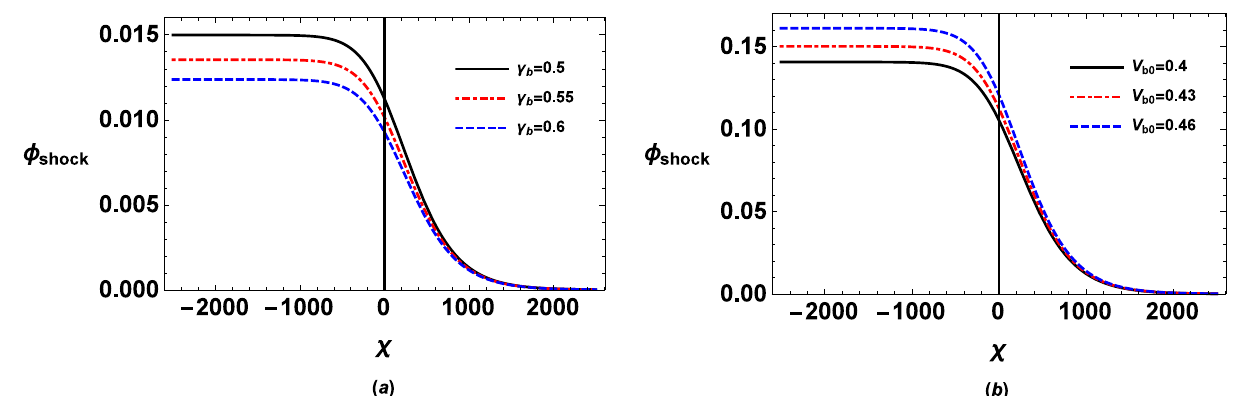
Figure 1. (Color online) Variation of the shock pulse profile for different values of ( a ) relativistic factor ( γ b ), ( b ) beam velocity ( V b 0 ), with fixed values of l z = 0.6, η = 0.4, µ b = 0.2 γ b = 0.5, H = 0.2 and T = 0.2.